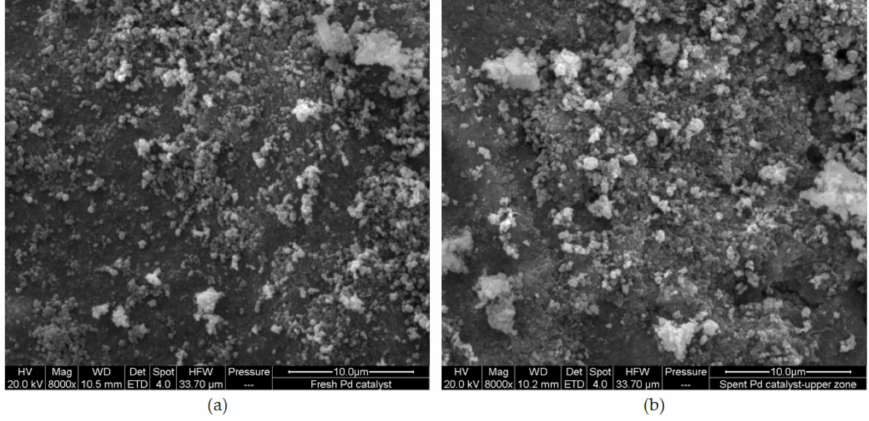
Figure 4. SEM images of ( a ) fresh and ( b ) spent Pd / Al 2 O 3 catalysts ( × 8000